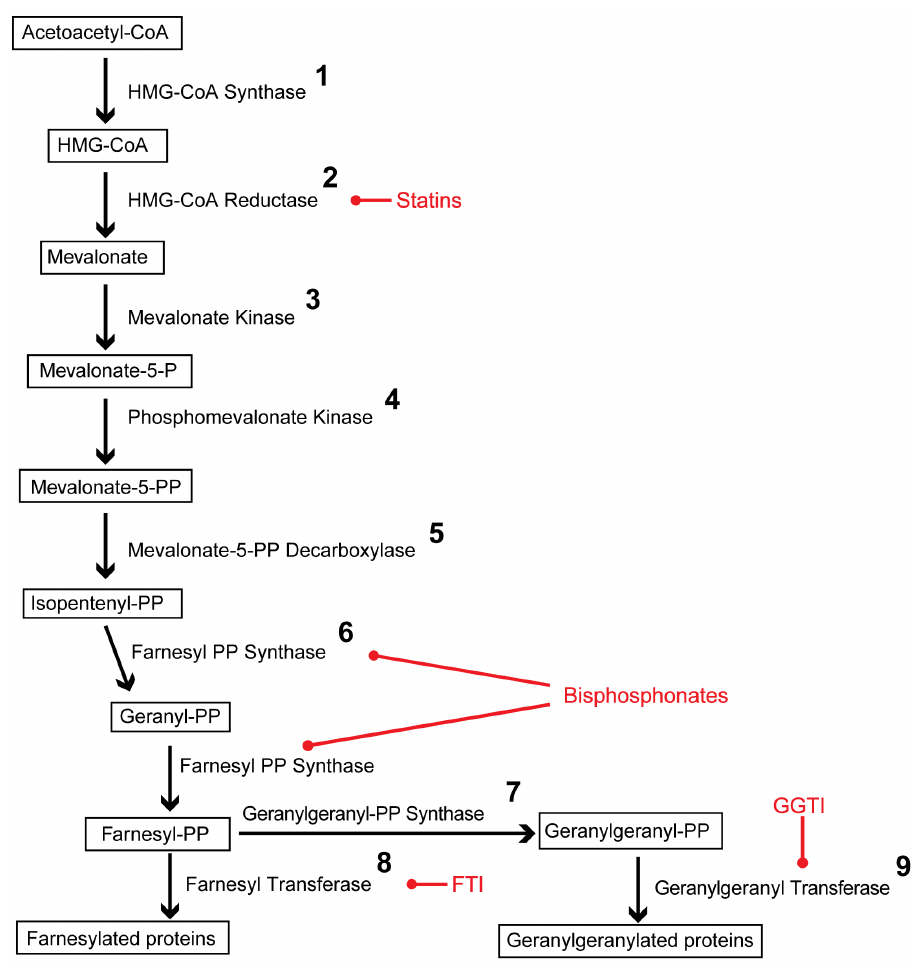
Figure 8. Overview of the mevalonate pathway in S.mansoni . The enzymes are numbered in bold typeface and their respective products are boxed; synthetic inhibitors are indicated in red. GenBank entries for each enzyme are: 1 - CCD58635; 2 - CAZ30720; 3 - CCD79354; 4 - CCD76423; 5 - CCD60126; 6 - CCD78373; 7 - CCD81269; 8 - a -subunit- XP_002580188; b -subunit- CCD82339; 9 - a -subunit- CCD77887; b -subunit- CCD79051. FTI = farnesyl transferase inhibitor; GGTI = geranylgeranyl transferase inhibitor.